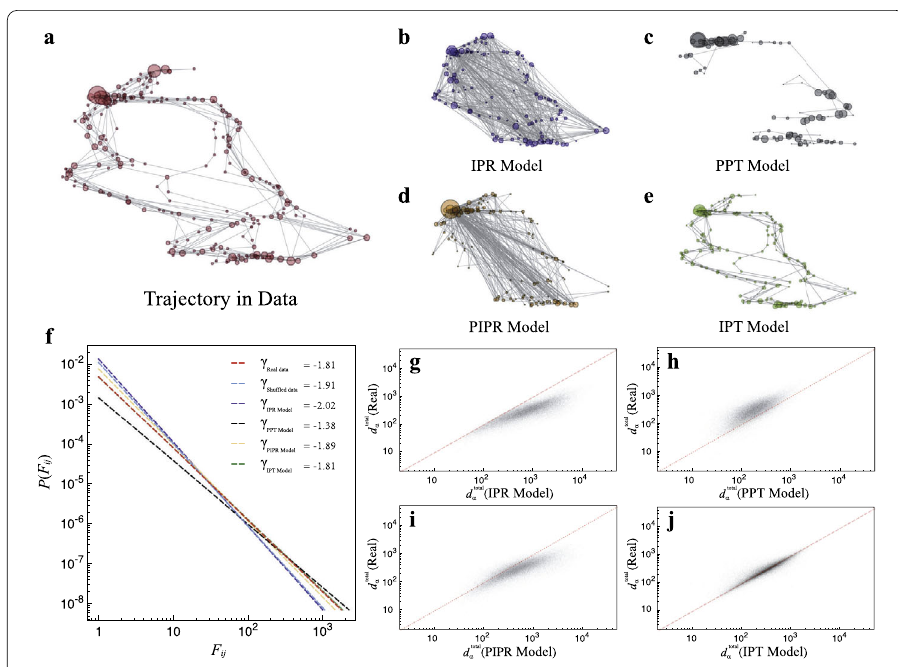
Figure 4 Quantitative comparison of the IPT model with three representative models. ( a ) The travel trajectory of a typical user in ( a ) the real data, and those simulated by ( b ) the IPR model, ( c ) the PPT model, ( d ) the PIPR model, and ( e ) the IPT model. For all the models, the relevant quantities are extracted from the real data of the selected user and used as the initial condition in the simulation. Here each node is a location visited by the user, with node size proportional to its visitation frequency generated by the corresponding model. ( f ) Comparison of the distributions of flux between location pairs, P ( F ij ), in the real and the shuffled data as well as the simulated trajectories from different models. The results of the fitted exponents suggest that the IPT model can best reproduce the flux distribution in real data. The scatter plots of the total traveled distance d total α of each user α between the real data and the simulated data by ( g ) the IPR model, ( h ) the PPT model, ( i ) the PIPR model, and ( j ) the IPT model